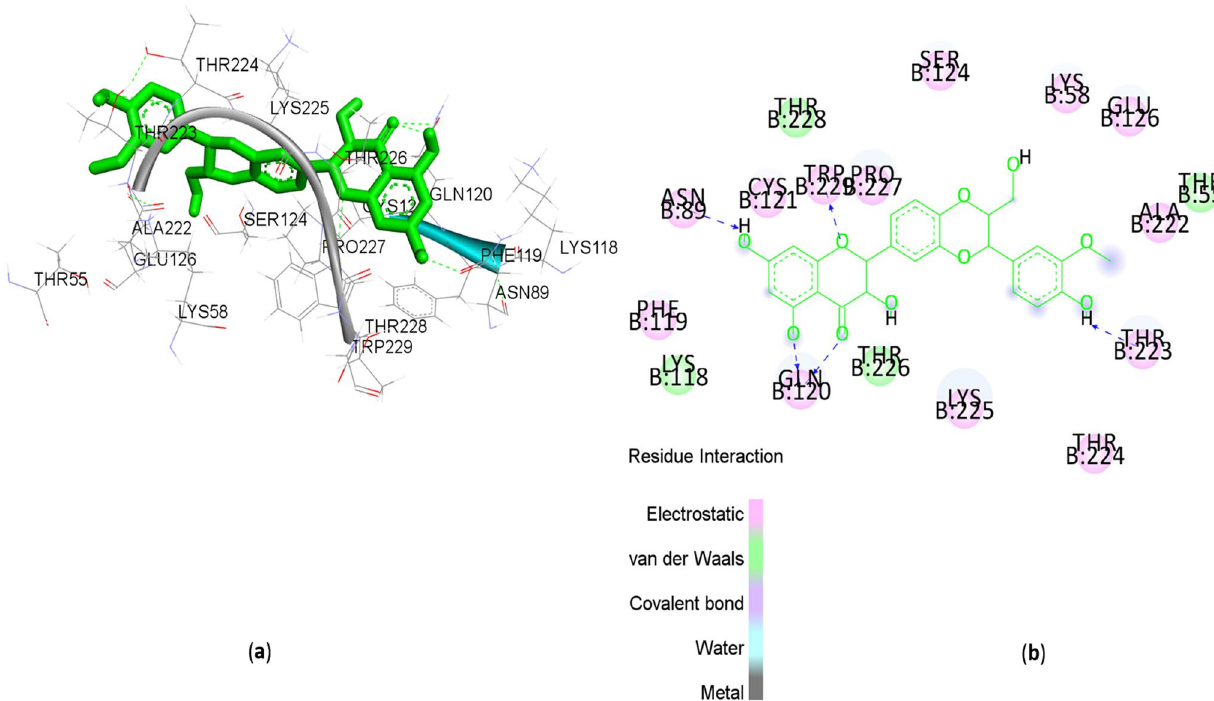
Figure 7. Interaction of silymarin with DENV E protein (1uzg). ( a ) 3D scheme of the silymarin interaction with DENV E protein (1uzg). ( b ) 2D scheme of silymarin interaction with DENV E protein (1uzg), including H-bonding and close contact. There are H-bonds at the (1uzg) E protein GLN120, TRP229, ASN89, and